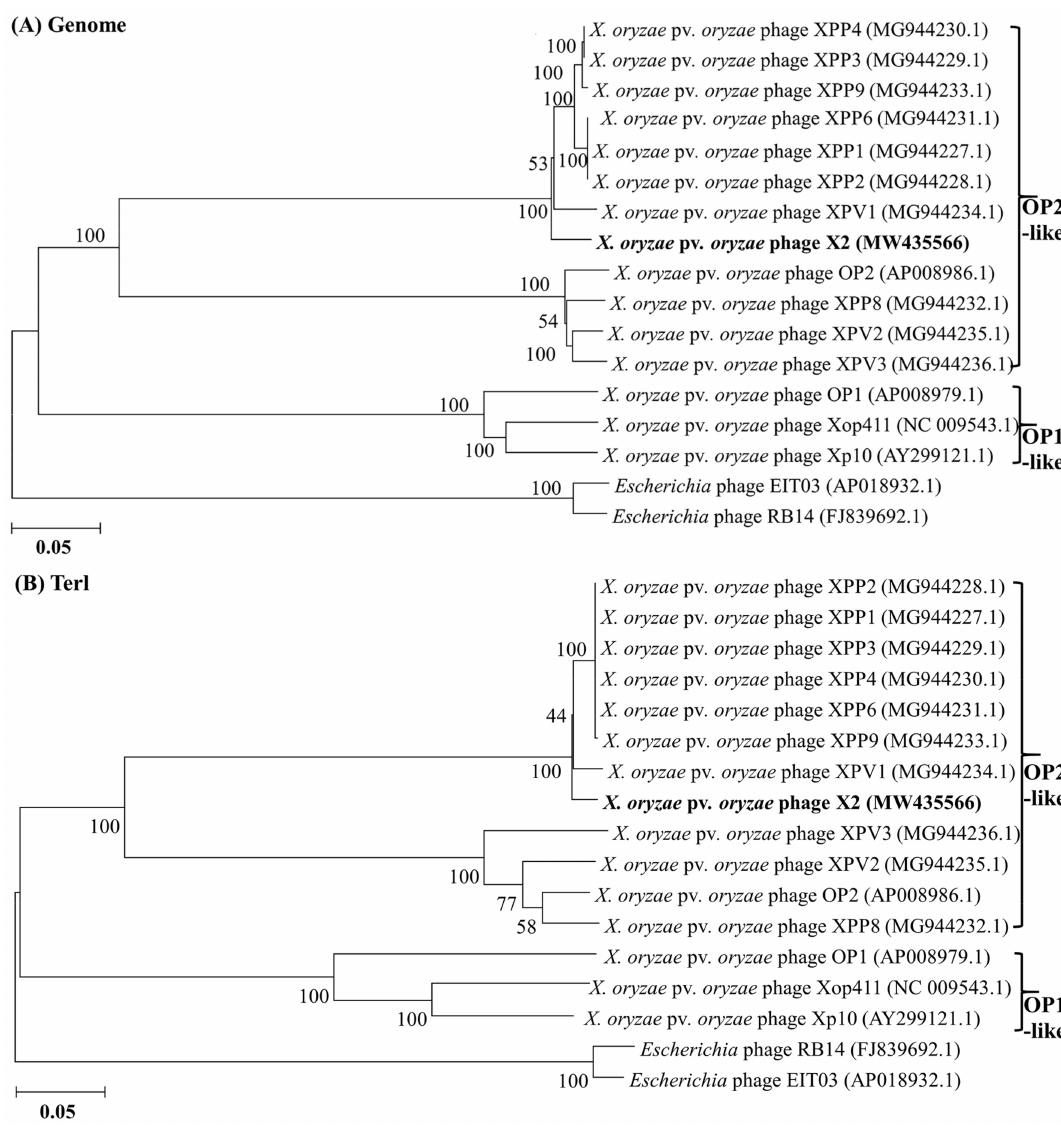
Figure 2. Neighbor-joining phylogenetic tree analysis of X2 phage. ( A ) Genome. ( B ) TERL. Bootstrap values of 1000 replications. Escherichia phage was used as the